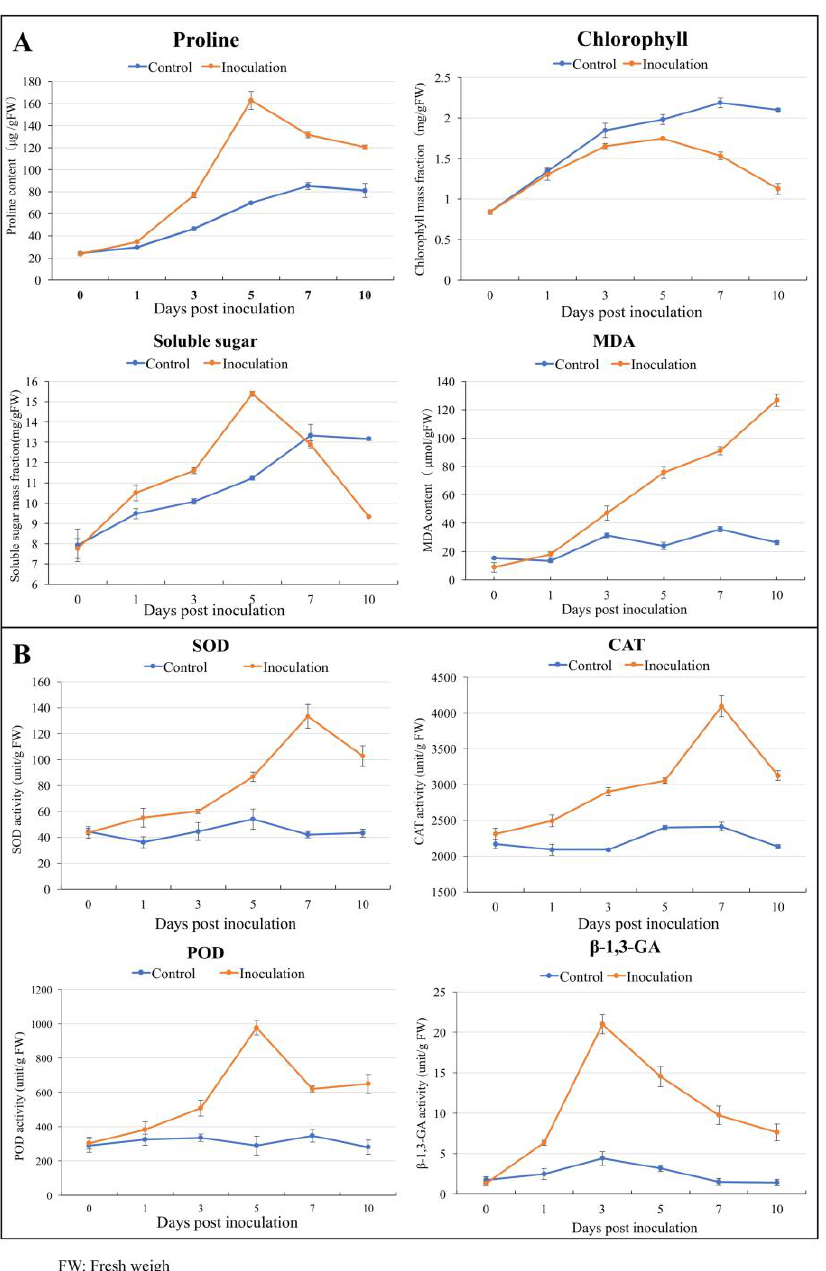
Figure 6. Physiological changes. ( A ) Effect of PM-infection on proline, chlorophyll, soluble sugars and malondialdehyde (MDA) content in apple leaves; ( B ) effect of PM on superoxide dismutase (SOD), catalase (CAT), peroxidase (POD) and β-1,3-glucanase (β-1,3-GA) activities in apple leaves. The leaves were incubated for various time intervals after PM inoculation. Each time point represents the mean of three measurements for each of the three biological replicates.